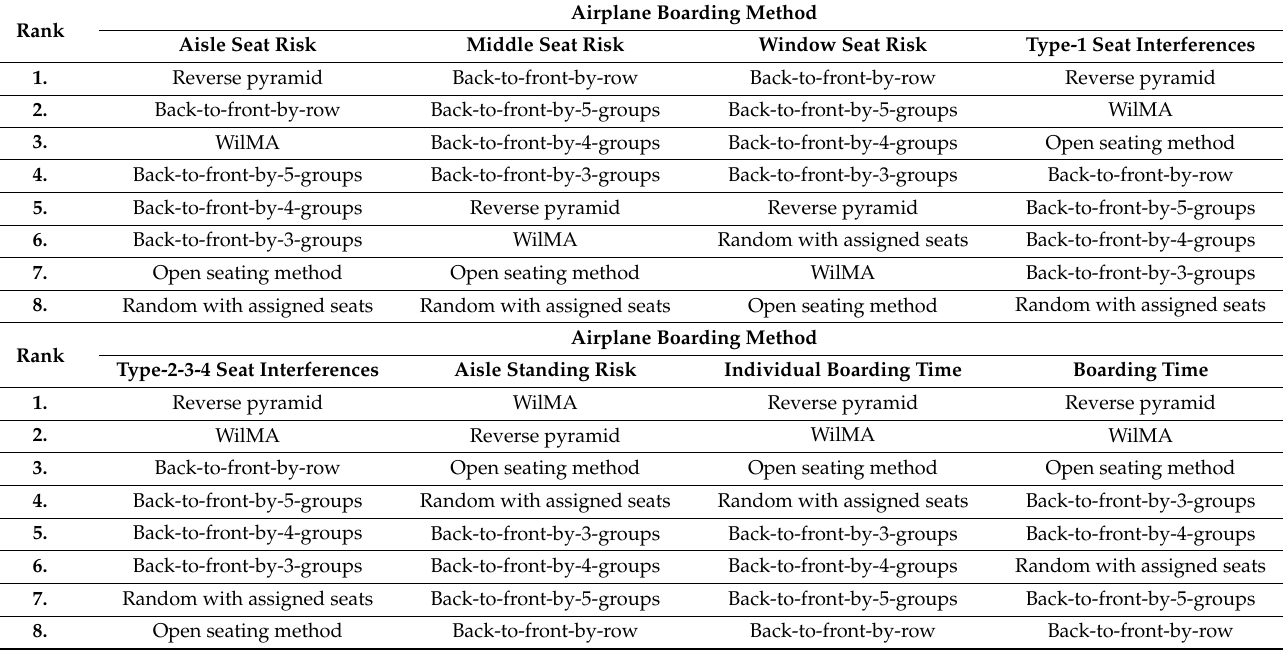
Table 11. Methods ranking based on the considered indicators in the S1 luggage